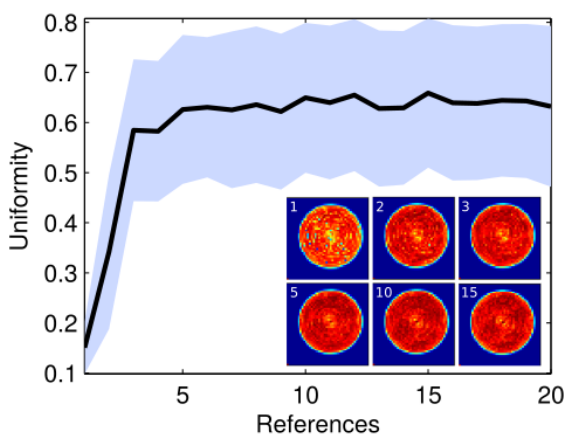
Fig. 2 : Uniformity measurement for 1-20 randomly chosen internal references. Inset shows intensity of all output modes across the fiber facet to visually compare homogenity.